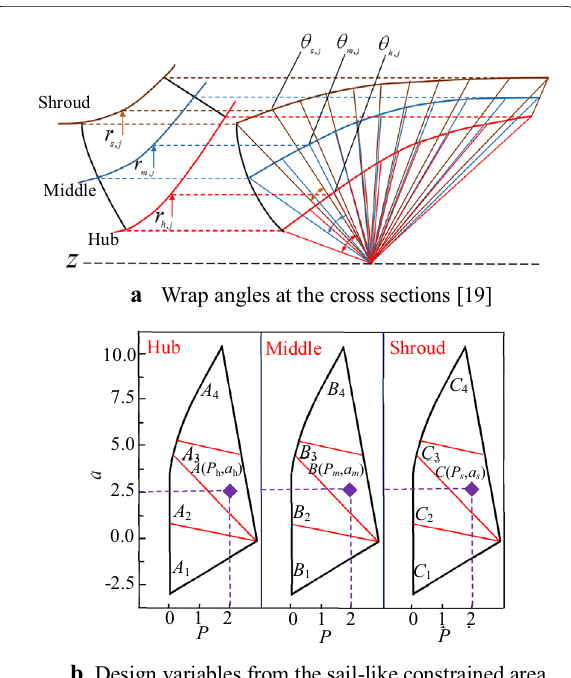
Wrap angles are stable?